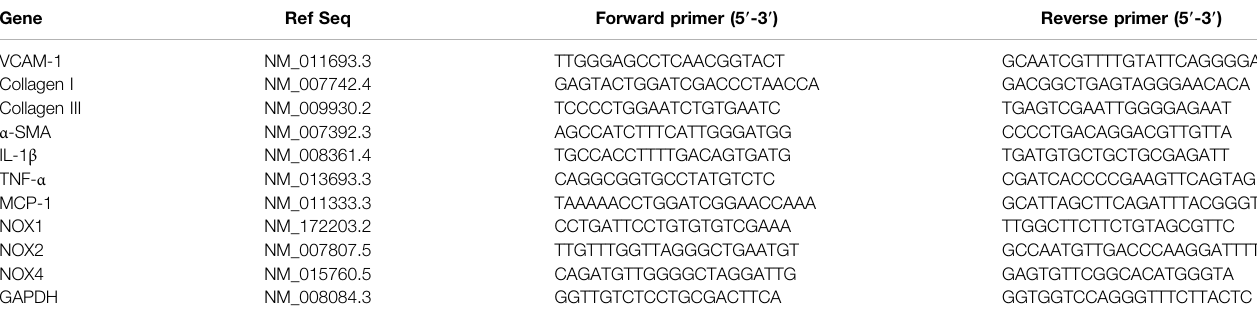
TABLE 1 | Primers used for quantitative real-time PCR